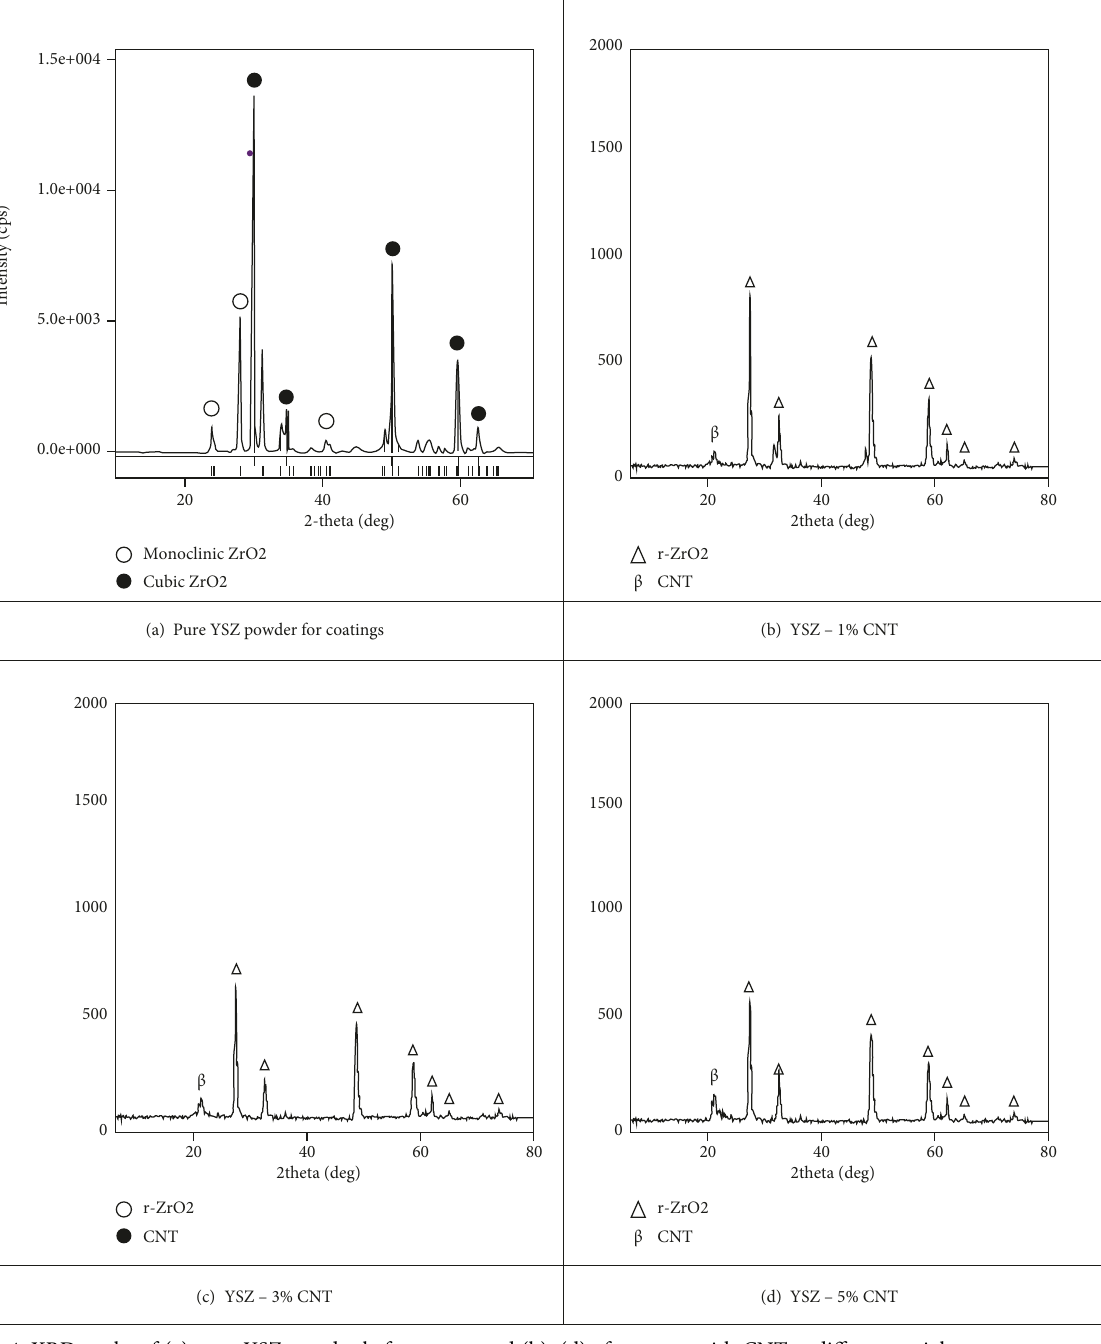
Figure 4: XRD peaks of (a) pure YSZ powder before spray and (b)–(d) after spray with CNT at different weight percentage proportions. (a) Pure YSZ powder for coatings. (b) YSZ-1% CNT. (c) YSZ-3% CNT. (d) YSZ-5%